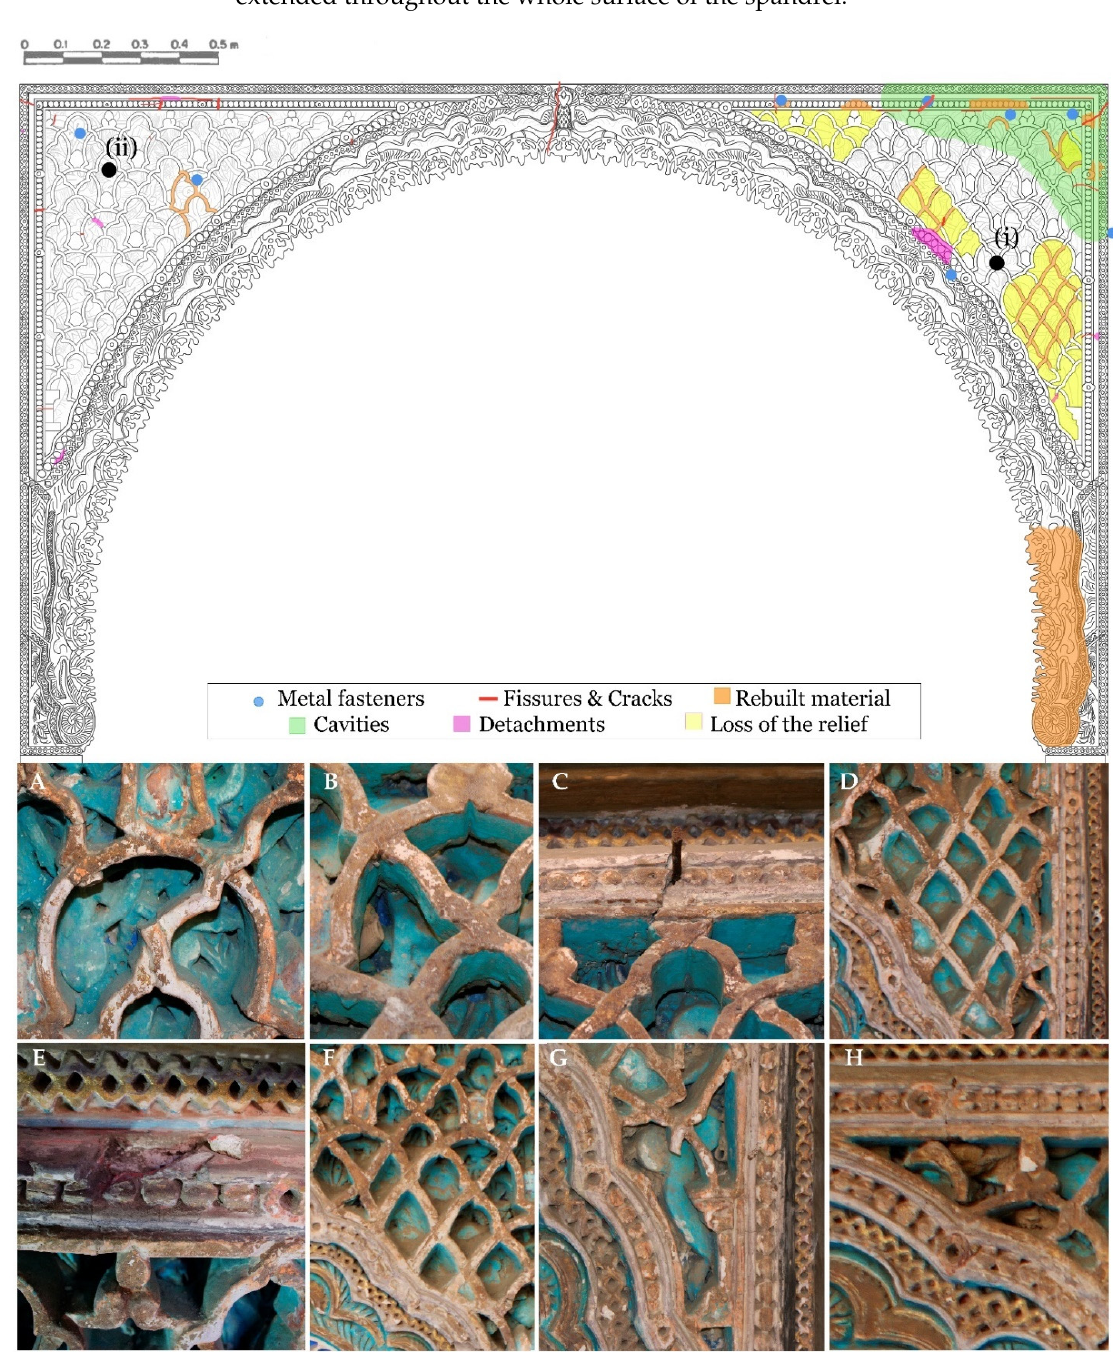
Figure 12. Mapping of alterations present in the spandrels of the arc of access to the STCV. ( A ) Types of deterioration present in the spandrels: ( A ) detachment and lack of repolychrome due to successive interventions, ( B ) presence of hornets, ( C ) presence of oxidized metal elements, ( D ) loss of the lower relief due to fillings with plaster/lime mortar, ( E ) detachment of part of the frame, ( F ) dirt, ( G ) detachment and hornet’s nest, and ( H ) fissure and presence of hornets ( B